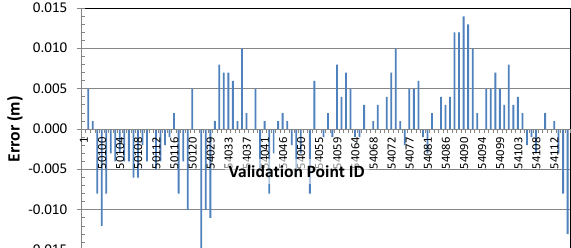
Figure 13. Plot of residuals of MTLS data from the average of 16 passes compared with total station data